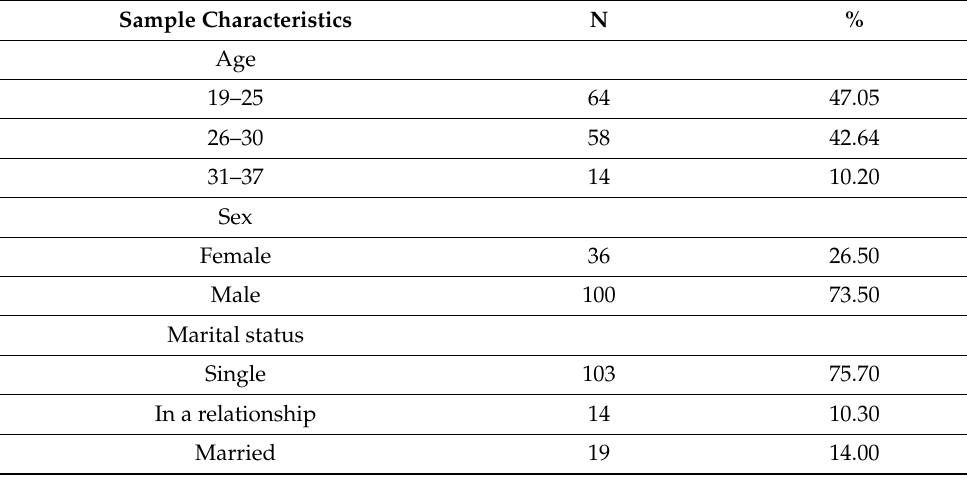
Table 1. Sample characteristics (socio-demographic and migration-specific